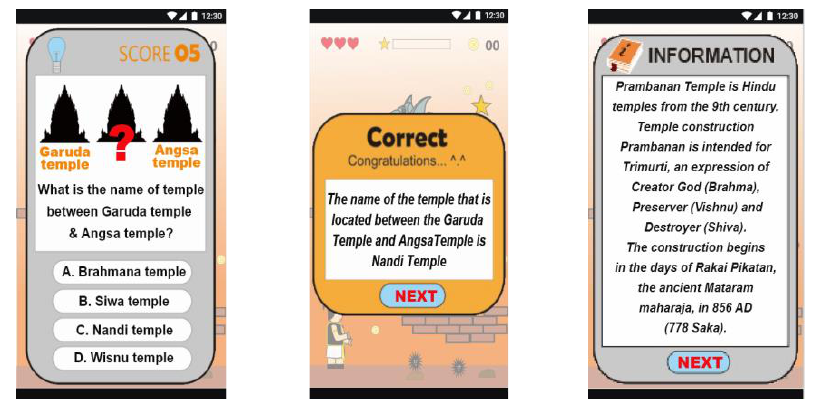
Fig. 6. The question, answer, information